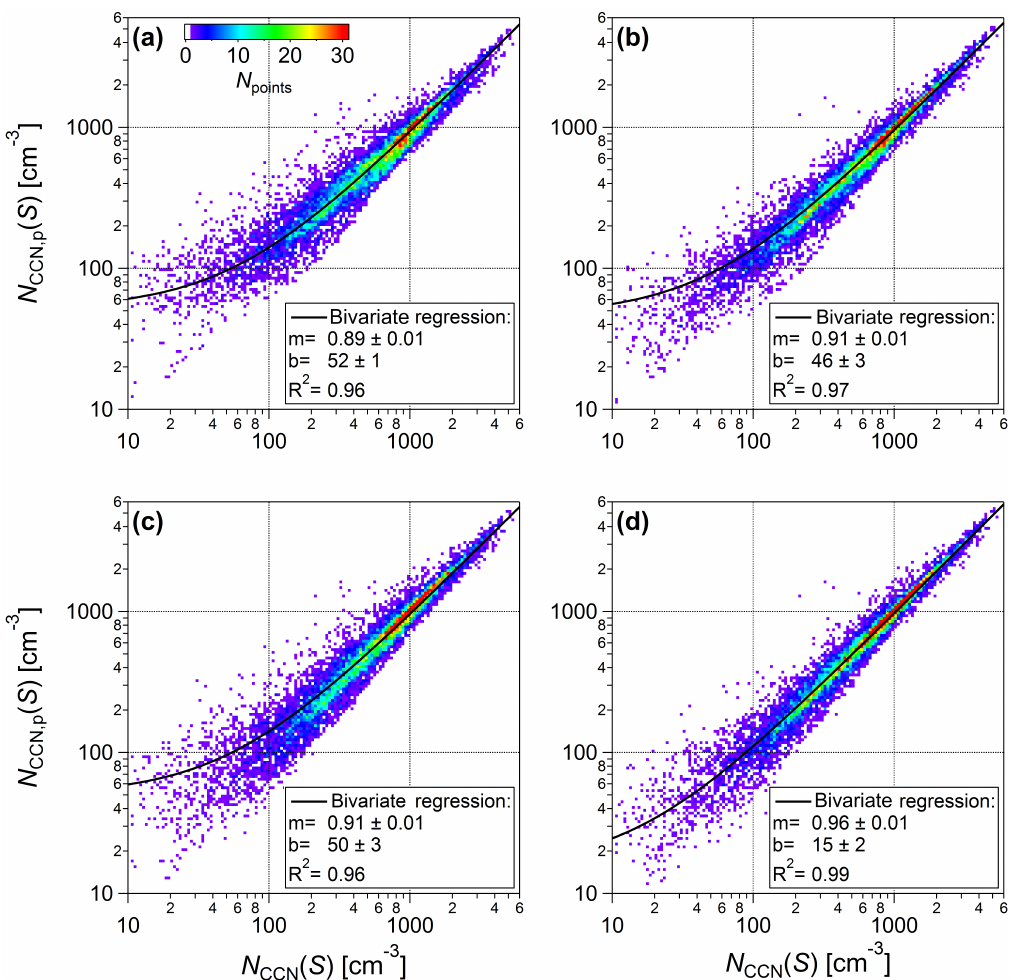
Figure 16. Predicted vs. measured CCN number concentrations, based on our novel parametrization using time-resolved aerosol number concentrations and average error function fits of CCN efficiency spectra. The panels show the following four variations of the parametrization: (a) erf fit of the annually averaged N CCN ( S)/N CN,10 vs. S efficiency plot, (b) erf fit of the annually averaged N CCN ( S)/N CN,50 vs. S efficiency plot, (c) erf fits of the N CCN ( S)/N CN,10 vs. S efficiency plot, resolved by seasons, and (d) erf fits of the N CCN ( S)/N CN,50 vs. S efficiency plot, resolved by seasons. This approach requires the following as input data: (i) a time series of total aerosol concentration (e.g., N CN,10 from a CPC measurement or N CN,50 as model output) and (ii) the parameters of the erf fit (e.g., as provided in Table 7). The color code shows the number of data points falling into the pixel area, following Jurányi et al. (2011). The black line represents a bivariate regression fit of the